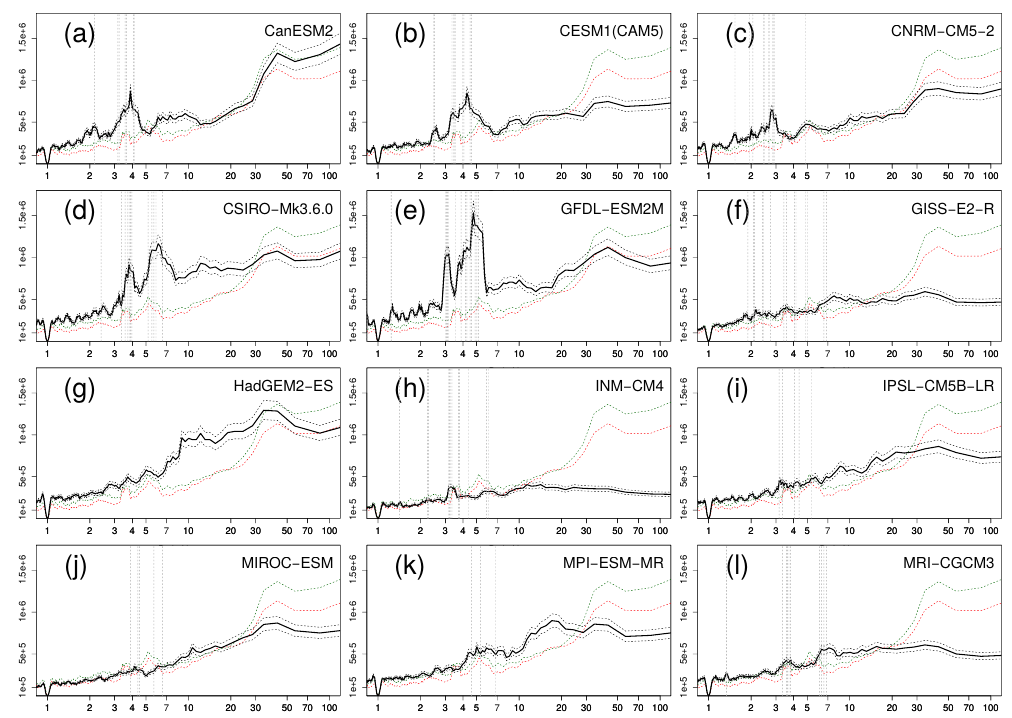
Figure 5. As Fig. 4a but now for each climate model (black line). The reanalysis spectra are shown as a reference (dashed green and red lines). The dashed vertical lines indicate the climate model multi-annual periods significant at 5%